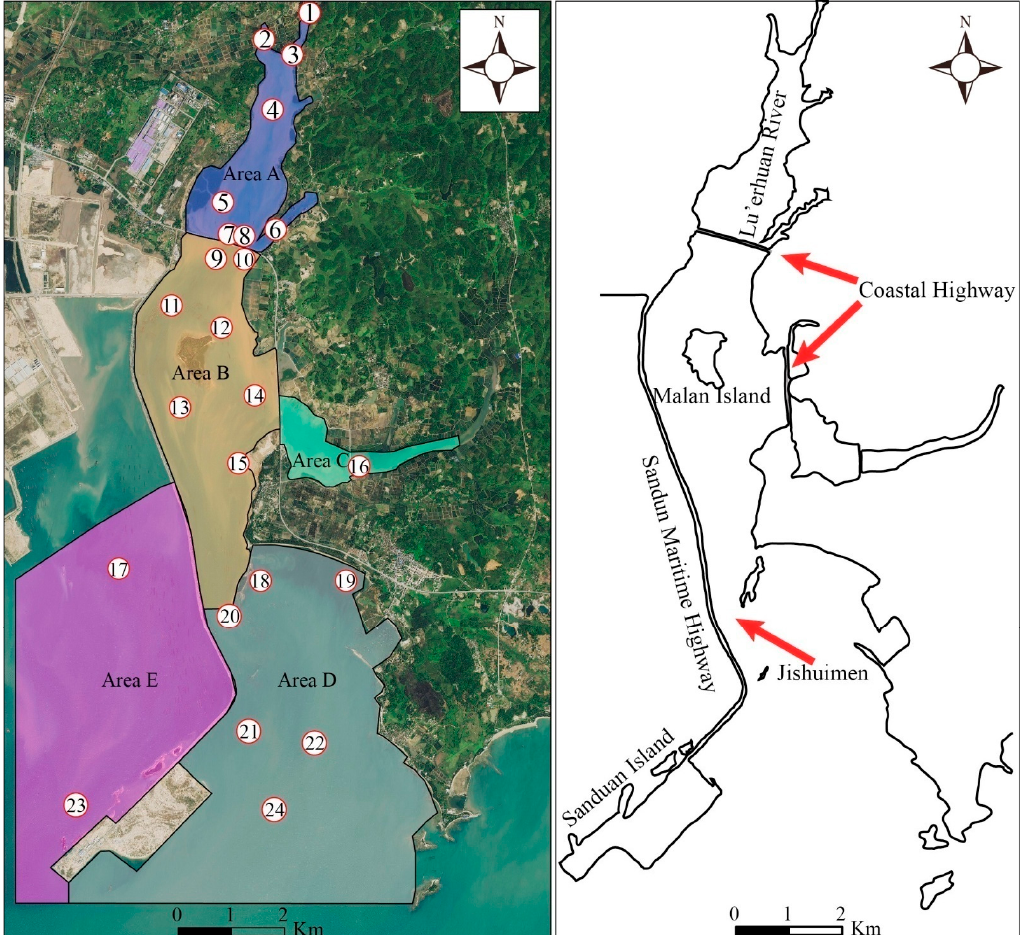
Figure 2. Map of sampling sites in the Lu’erhuan River Sea area of Qinzhou Bay, Guangxi Province. The remote sensing image ( the left ) and diagram ( the right ) of the study area. The colored shaded areas in the left panel are the five study areas A, B, C, D, E, and the circles in red and marked with serial numbers represent the sampling points. The right panel shows a sketch of the outline of study area.